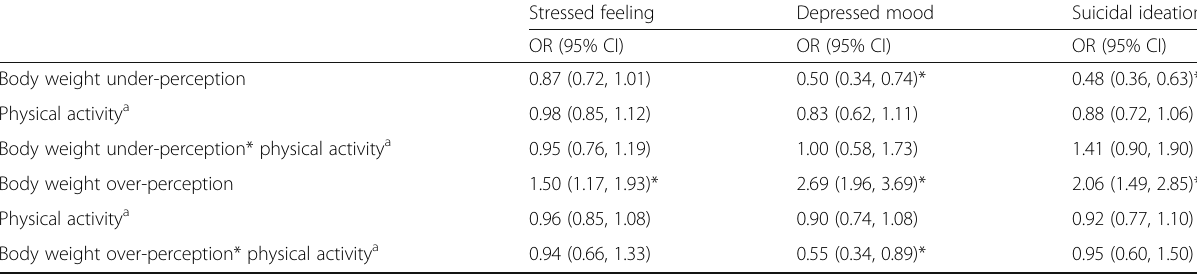
Table 2 Unadjusted main and interaction effects of body weight misperception and physical activity on psychological distress among young South Korean adults aged 20 to 39 years — 2010 – 12 Korea National Health and Nutrition Examination Survey (KNHANES) ( N =